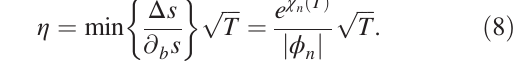
i Þ t Þ and n ð